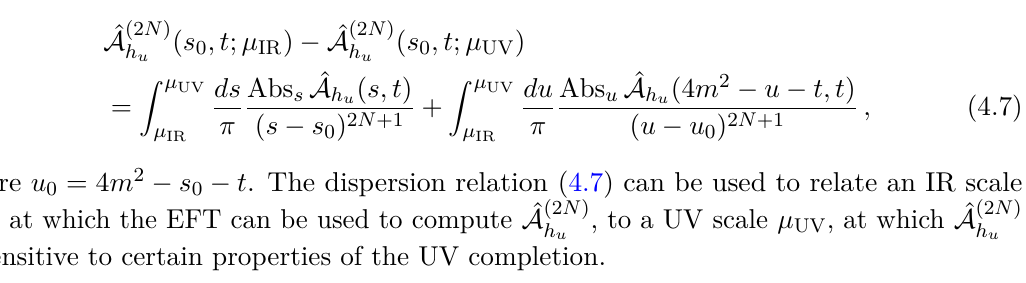
ˆ in (4.6) (shown in green). A (2 N ) h u